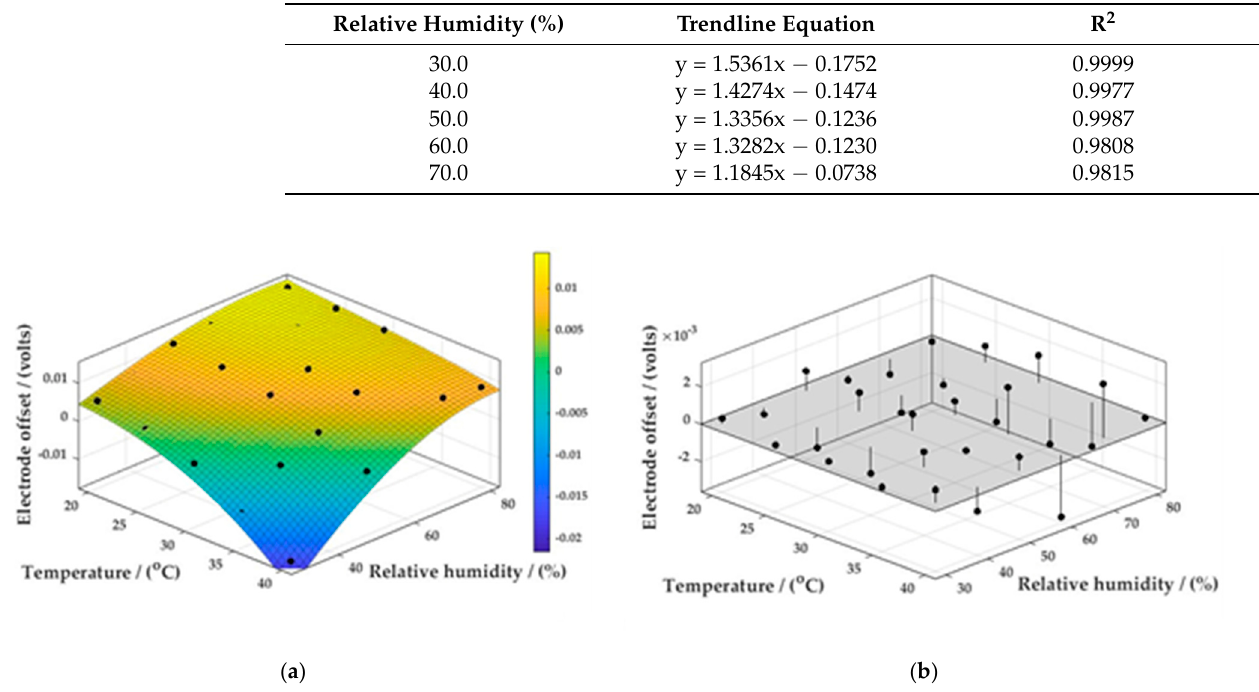
Figure 7. ( a ) MATLAB surface function of offset between working to auxiliary electrode across an environmental envelope. ( b ) Residuals plot of actual values to surface function.